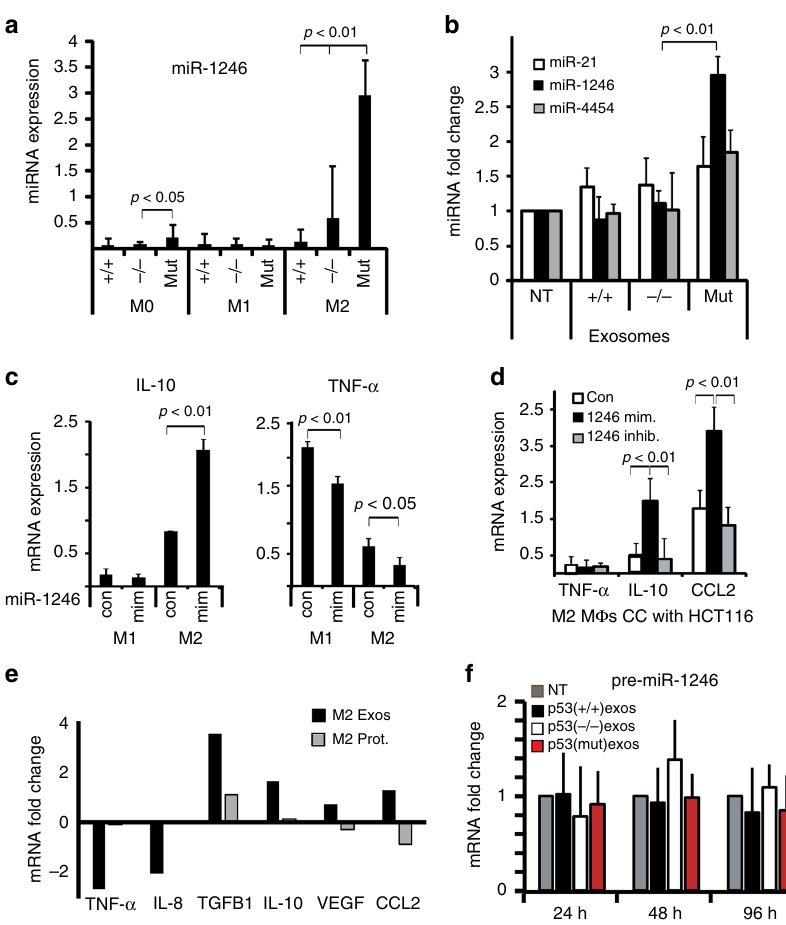
Fig. 3 Exosomes shed from mutp53 tumor cells carry speci fi c microRNA cargo. a Macrophages were co-cultured with HCT116 cells. RNA was extracted from the macrophages and subjected to qPCR analysis with primers speci fi c to miR-1246. Values were normalized for RNU48 in the same sample. b Macrophages were grown in the presence of 10 µ g exosomes isolated from HCT116 cells differing by their p53 status. miR-1246, miR-21, and miR-4454 levels were measured as in a . c M1 and M2 macrophages were transfected with LNA-miR-1246 mimic (mim) and compared with an equivalent control vector (con). RNA was extracted from the macrophages and subjected to qPCR analysis with primers speci fi c to TNF- α and IL-10. d HCT116 mutp53 (R248W) cells were transfected with LNA-miR-1246 mimic (mim) or miR-1246 inhibitor (inhib.) and compared with an equivalent control vector (con). Forty-eight hours later, cells were co-cultured with M2 macrophages for an additional 3 days after which RNA was extracted from the macrophages and subjected to qPCR analysis with primers speci fi c to TNF- α , CCL2, and IL-10. e Exosomes were isolated from HCT116 cells harboring mutp53 and separated from free proteins by a size-exclusion column. Macrophages were incubated with either pbs negative control (Con), the exosomes fraction (Exos) or the free proteins fraction (Prot.). RNA was extracted from the macrophages and subjected to qPCR analysis with primers speci fi c to the indicated genes. Data are presented as fold changes compared with a PBS-treated control. f M2 macrophages were grown in the presence of 10 µ g exosomes isolated from HCT116 cells differing by their p53 status for different time periods. RNA was extracted from the macrophages and subjected to qPCR analysis with primers speci fi c to pre-miR-1246. All experiments in this fi gure were repeated three times, error bars represent standard